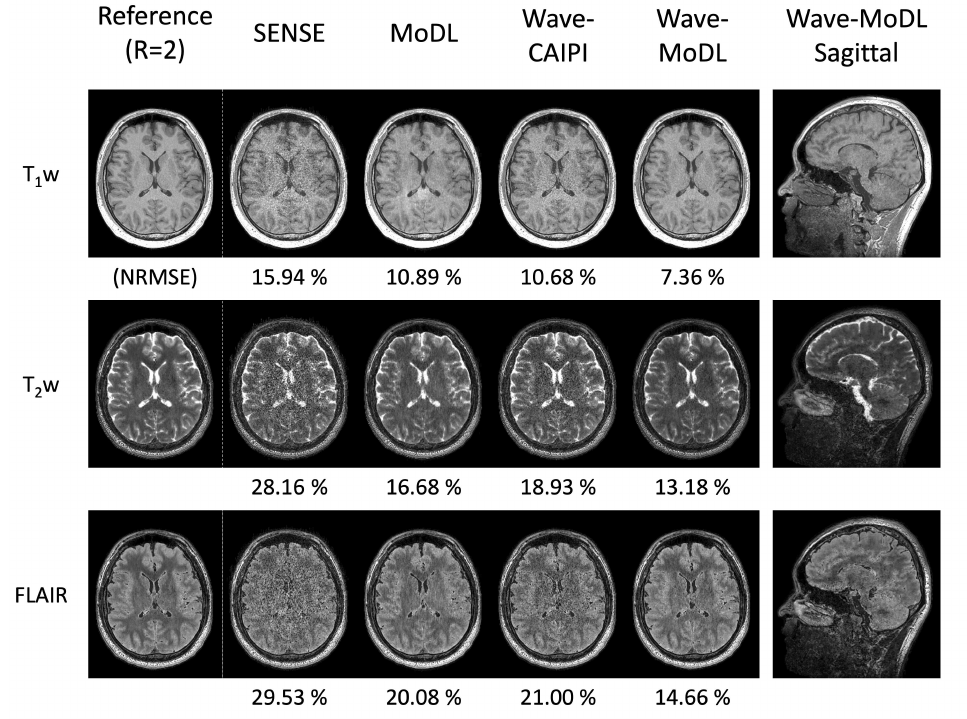
Figure 8. The synthesized T 1 w, T 2 w, and FLAIR images at R = 4 × 3-fold